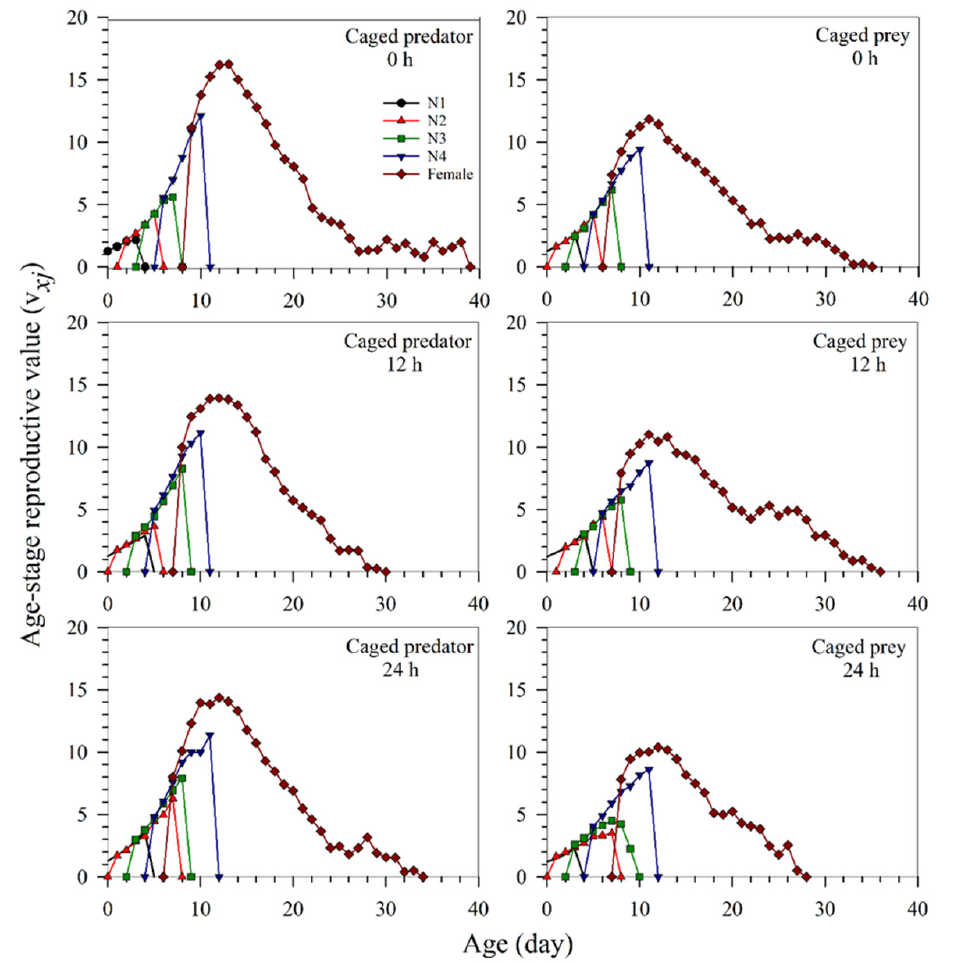
Figure 5. The age-stage specific reproductive value ( v xj ) of Sitobion miscanthi reared under predator Coccinella septempunctata risk at different exposure times (0, 12, and 24 h) with either the caged predator or caged prey treatments. N: Nymphal instar of S. miscanthi.